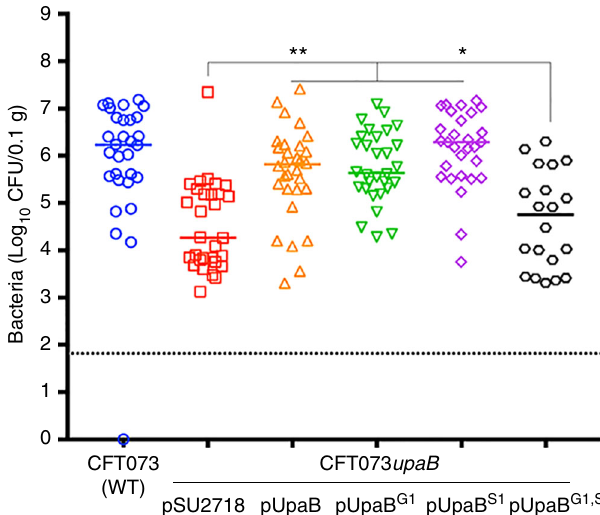
Fig. 5 UPEC colonisation of the mouse bladder is enhanced by UpaB GAG- and fi bronectin-binding interactions. C57BL/6 mice were challenged transurethally with wild-type CFT073, CFT073 upaB (pSU2718), CFT073 upaB (pUpaB), CFT073 upaB (pUpaB G1 ), CFT073 upaB (pUpaB S1 ) and CFT073 upaB (pUpaB G1, S1 ). The results represent log 10 CFU/0.1 g bladder tissue of individual mice at 24 h post-infection, and the horizontal bars mark group medians. A minimum of 20 mice were assessed per group (pooled from at least 2 independent experiments). Data were compared using Kruskal – Wallis analysis of variance (ANOVA) with Dunn ’ s multiple comparisons correction (* P < 0.05; ** P <